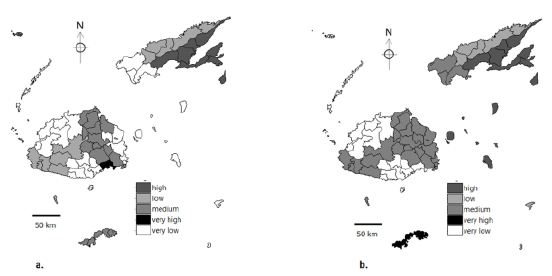
Figure 11a . LUI of farms of 3-5 size. Figure 11b. LUI of farms of 5-10ha size.